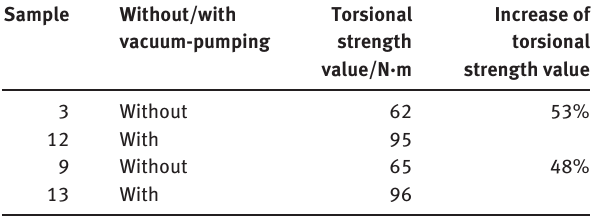
Table 4 Comparative torsional strength value as a function of vacuum-pumping